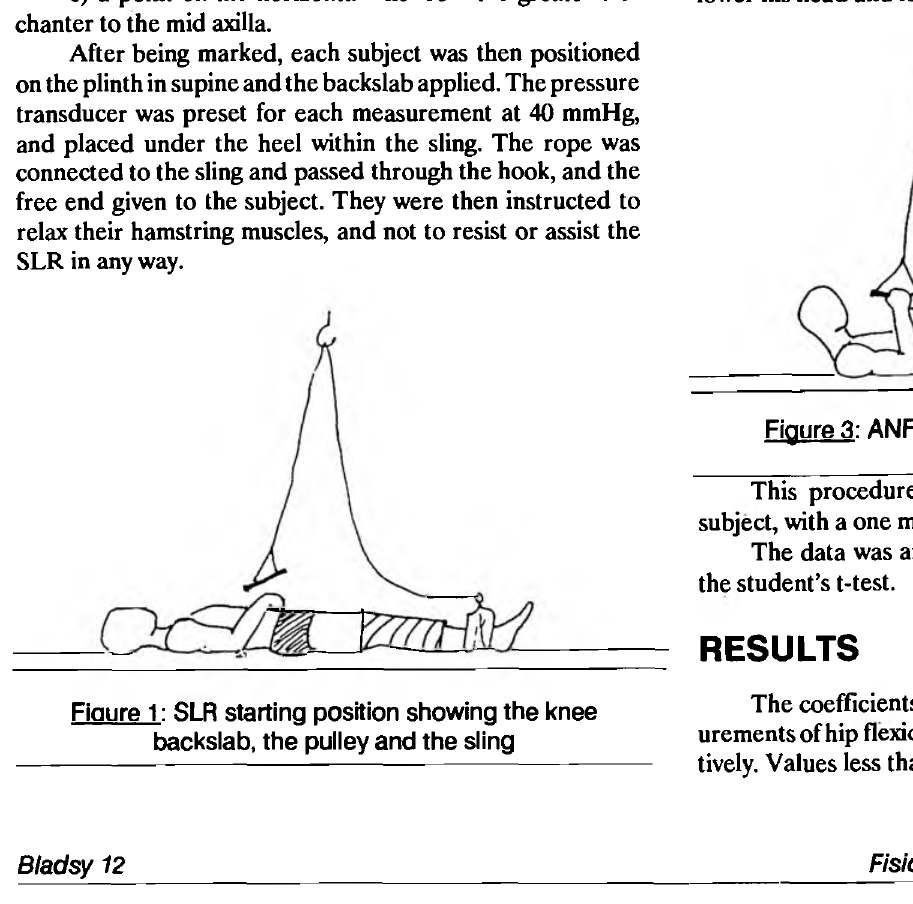
Figure 3: ANF superimposed on passive